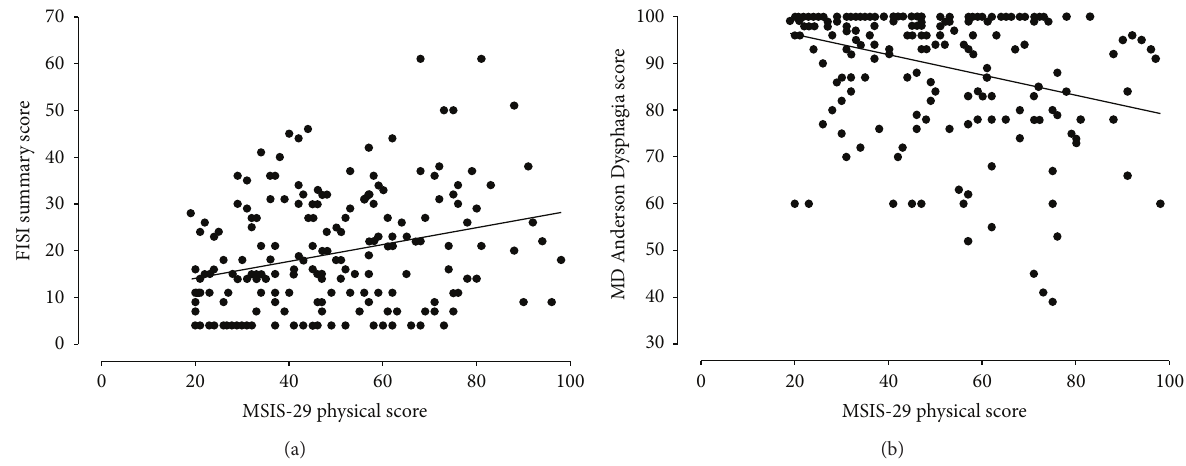
Figure 2: Association between the physical score of the MSIS-29 and scores on the Fecal Incontinence Severity Index (FISI) (a) ( 𝑟 2 = 0.28 , 𝑃 < 0.01 ) or the MD Anderson Dysphagia Inventory (b) ( 𝑟 2 = −0.36 , 𝑃 < 0.01 ).